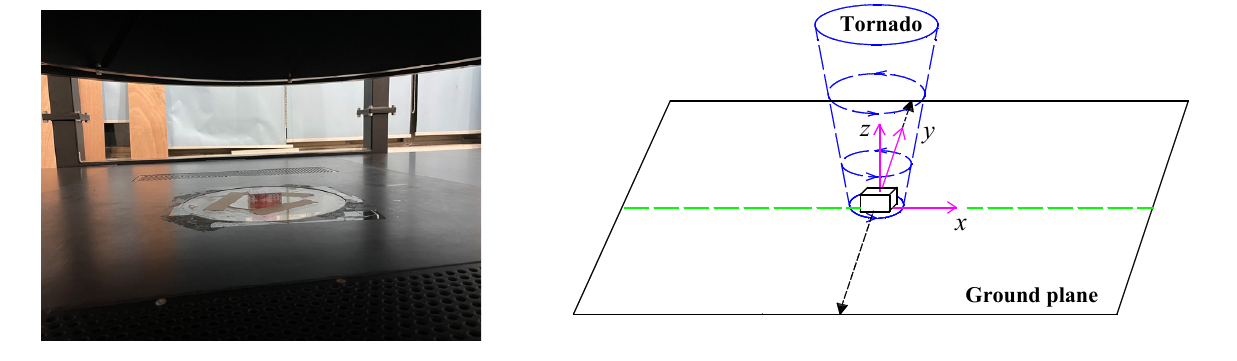
Figure 4. Test configurations. Figure 4. Test con fi gurations. Table 3. Test Table 3. Test parameters.